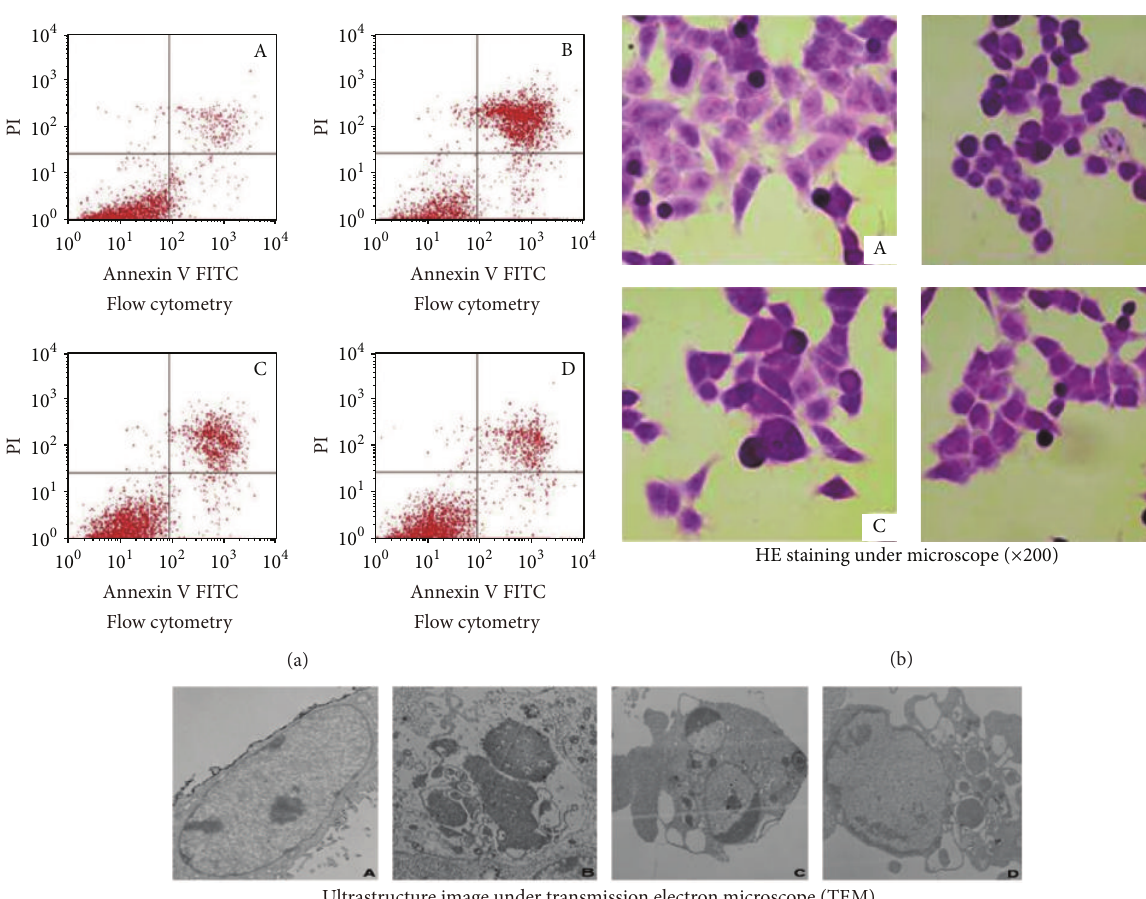
Figure 2: Effect of Bufalin on cell apoptosis. Flow cytometry on Annexin V/PI double stained cells showed that the apoptosis rates in the Bufalin-treated cells were significantly higher than that in the control group ( 𝑃 < 0.01 ) with dose-dependence. HE stained untreated cells appeared to be irregular spindle or polygon with cell mitosis (A), while the morphological changes of Bufalin-treated cells included cell dwindlement and shrinkage (C, D) or the spherical cell shape (B) and enlarged intercellular space (C, D) or disappeared connection (B) between the cells, chromatin condensation, and decreased mitosis. The ultrastructure changes included plasmatic rarefaction and chromatin margination (D), cytoplasmic scattering (C), chromatin condensation (C), and apoptotic body (B, C). Bufalin concentration: A: control, B: 3 𝜇 M, C: 0.3 𝜇 M, and D: 0.03 𝜇